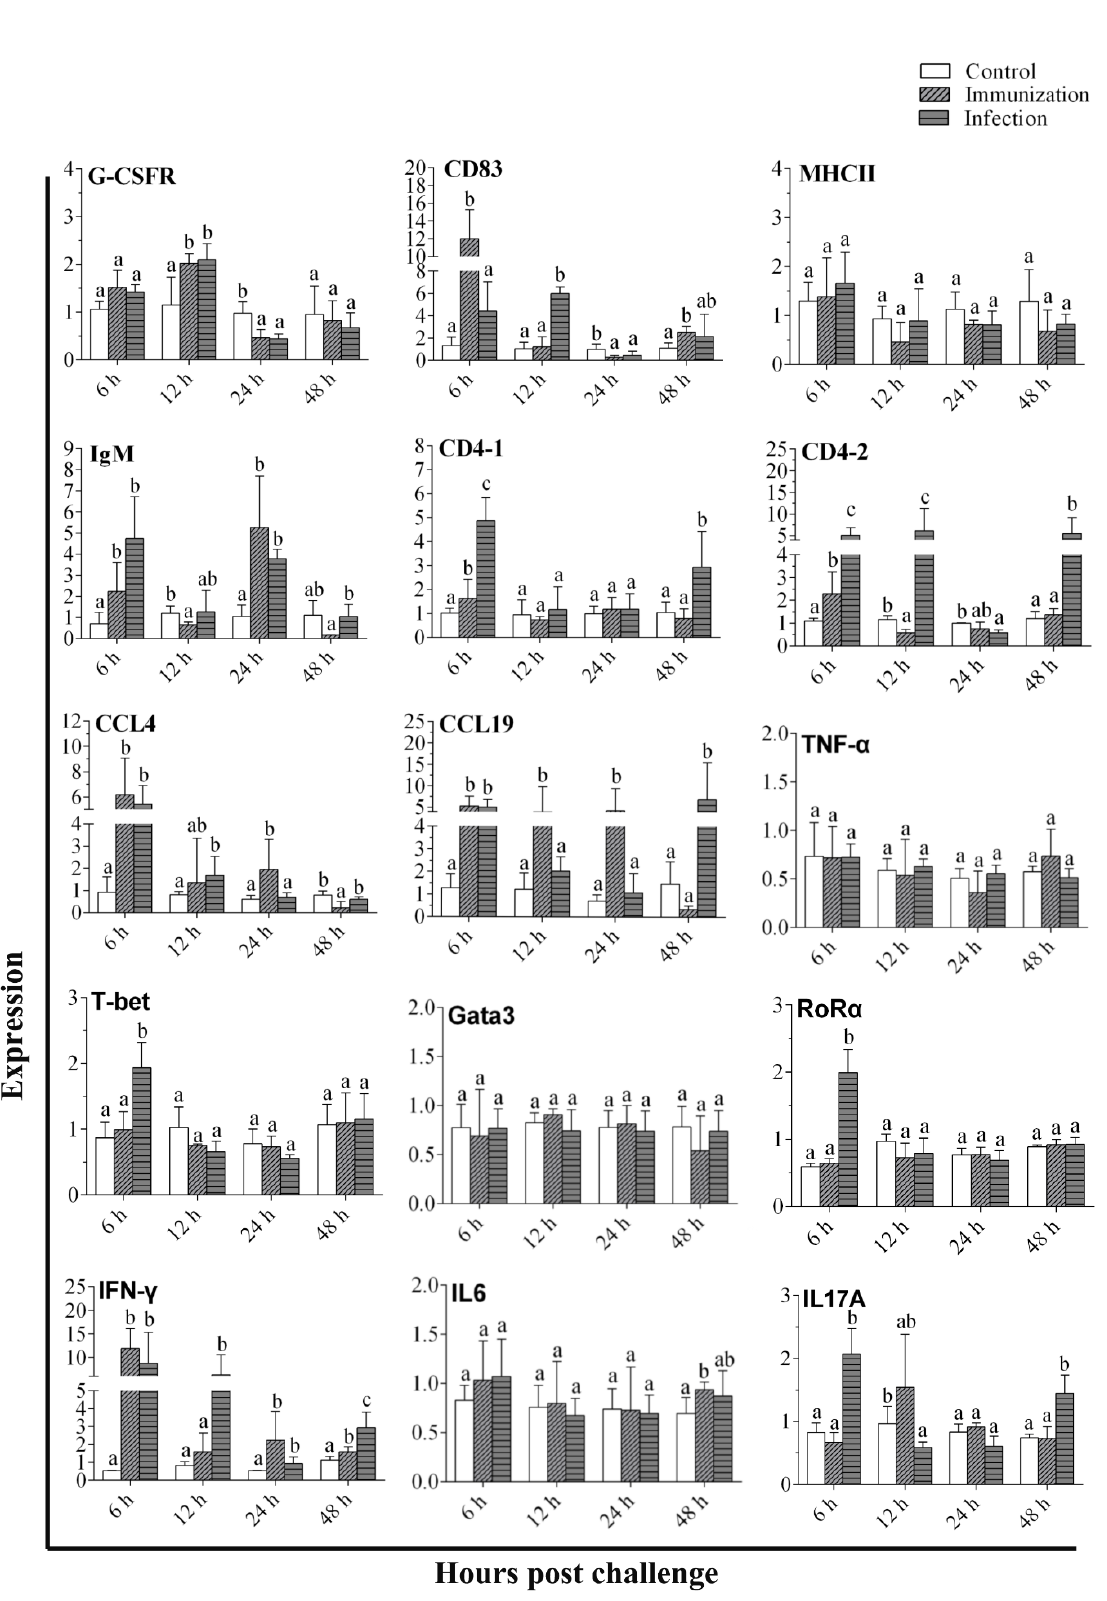
Figure 6. Analysis of the genes in response to V. anguillarum infection, vaccination, and PBS in PerC cells. The results are presented as the means ± SD. Different letters on the bar represent the statistical significance ( p < 0.05) of difference between the experimental and control groups.